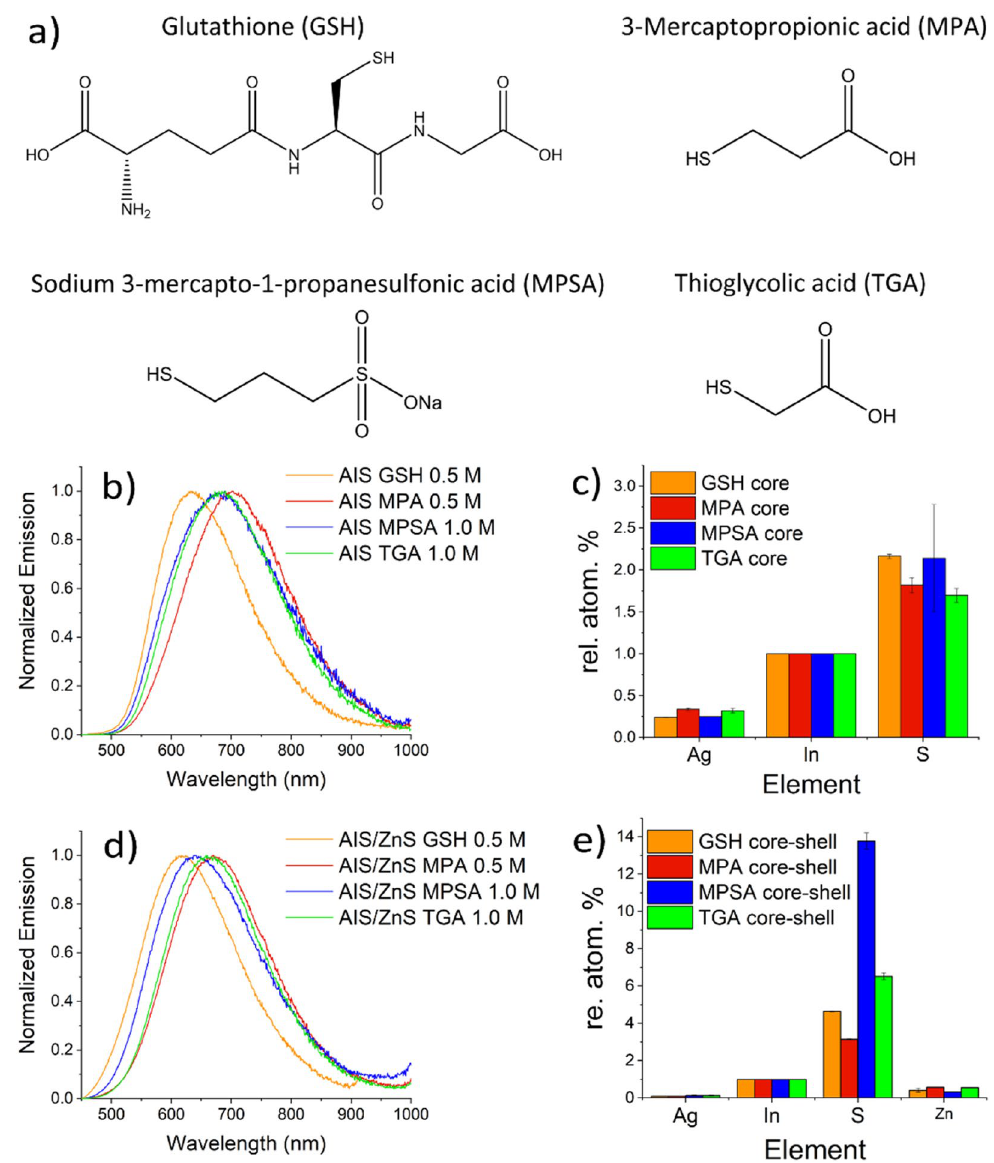
Figure 5. ( a ) Chemical structures of thiol ligands L-reduced glutathione (GSH), 3-mercaptopropionic acid (MPA), sodium 3-mercapto-1-propane sulfonic acid (MPSA), and thioglycolic acid (TGA). Normalized emission spectra and relative element concentrations of the AIS core QDs ( b , c ) and AIS/ZnS QDs ( d , e